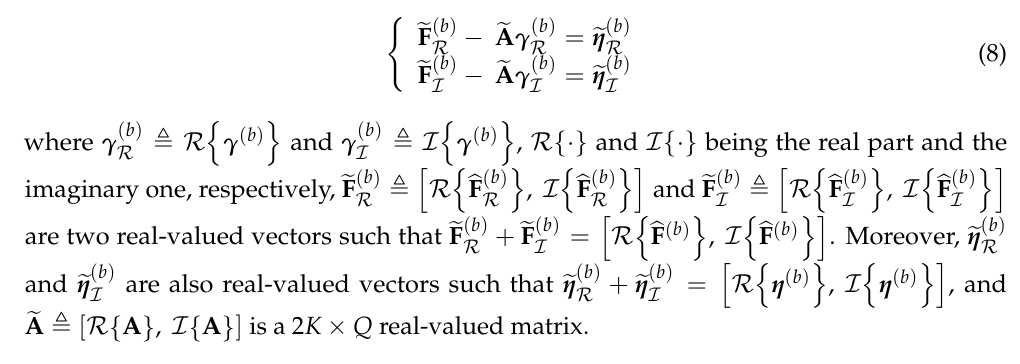
Figure 4. Numerical Assessment ( M = 16, d = λ layout of the plank and of ( b ) the B radiated power patterns when the sparse CPA is fed with ( c ) the corresponding sets of complex